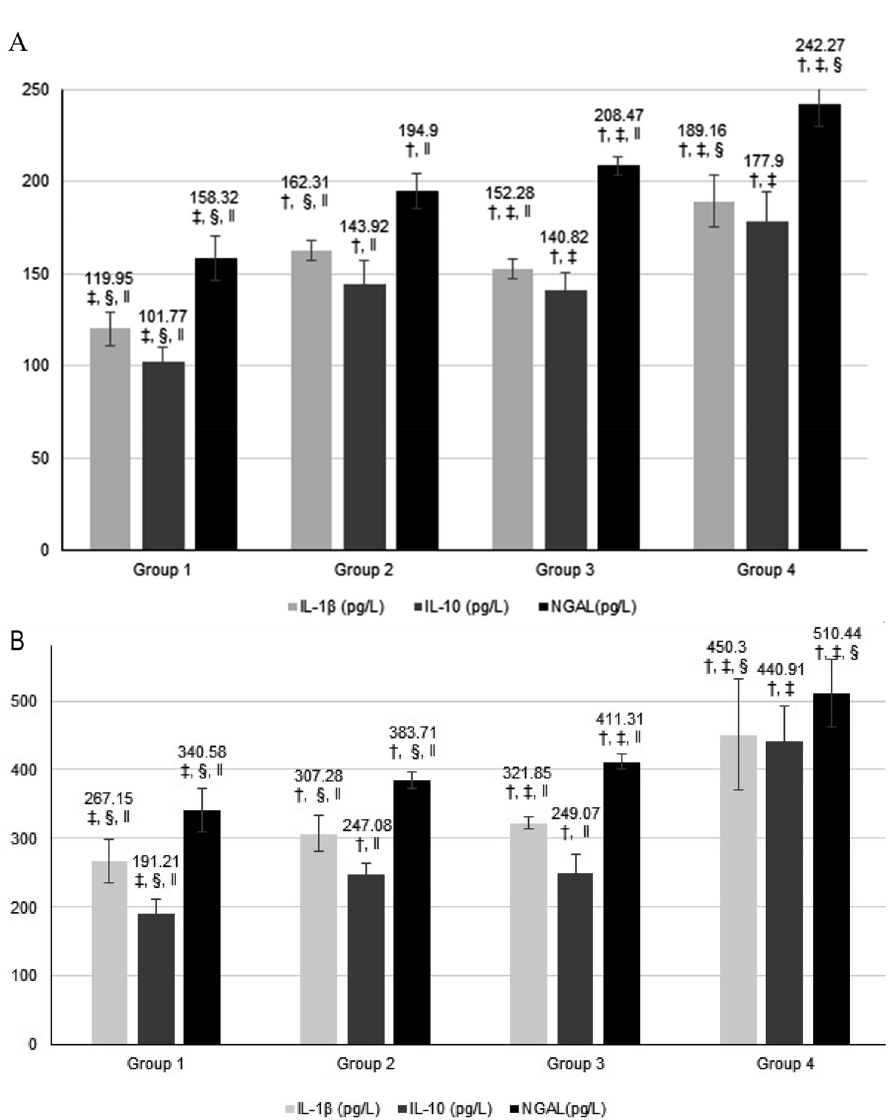
Figure 1- A: Salivary IL-1 β, IL-10, and NGAL levels, B: Serum IL-1 β, IL-10, and NGAL levels and comparisons between groups. †: significantly different than Group 1, ‡: significantly different than Group 2, §: significantly different than Group 3, ‖: significantly different than Group 4 (p<0.05, ANOVA and Tukey’s